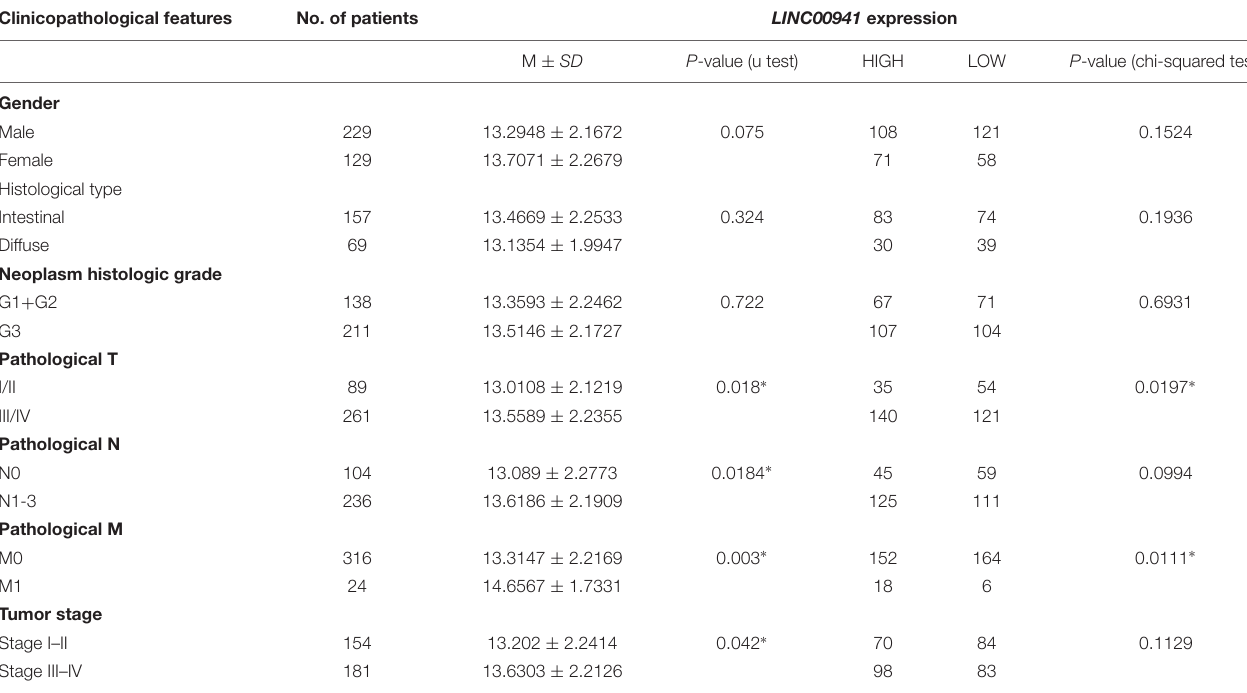
TABLE 1 | Associations between the expression of LINC00941 and clinicopathological features in GC. Clinicopathological